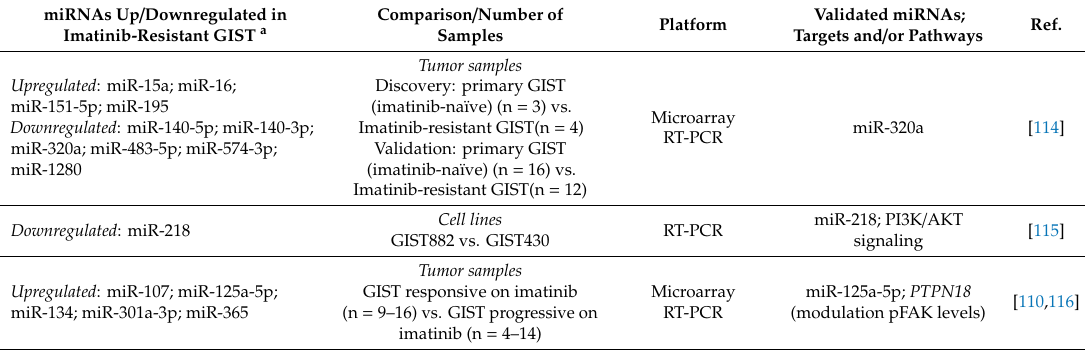
Table 3. MicroRNAs Associated with Imatinib Resistance in Gastrointestinal Stromal Tumors. miRNAs Up / Downregulated in Imatinib-Resistant GIST a Upregulated : miR-15a; miR-16; miR-151-5p; miR-195 Downregulated : miR-140-5p; miR-140-3p; miR-320a; miR-483-5p; miR-574-3p; miR-1280 Downregulated : miR-218 Upregulated : miR-107; miR-125a-5p; miR-134; miR-301a-3p; miR-365